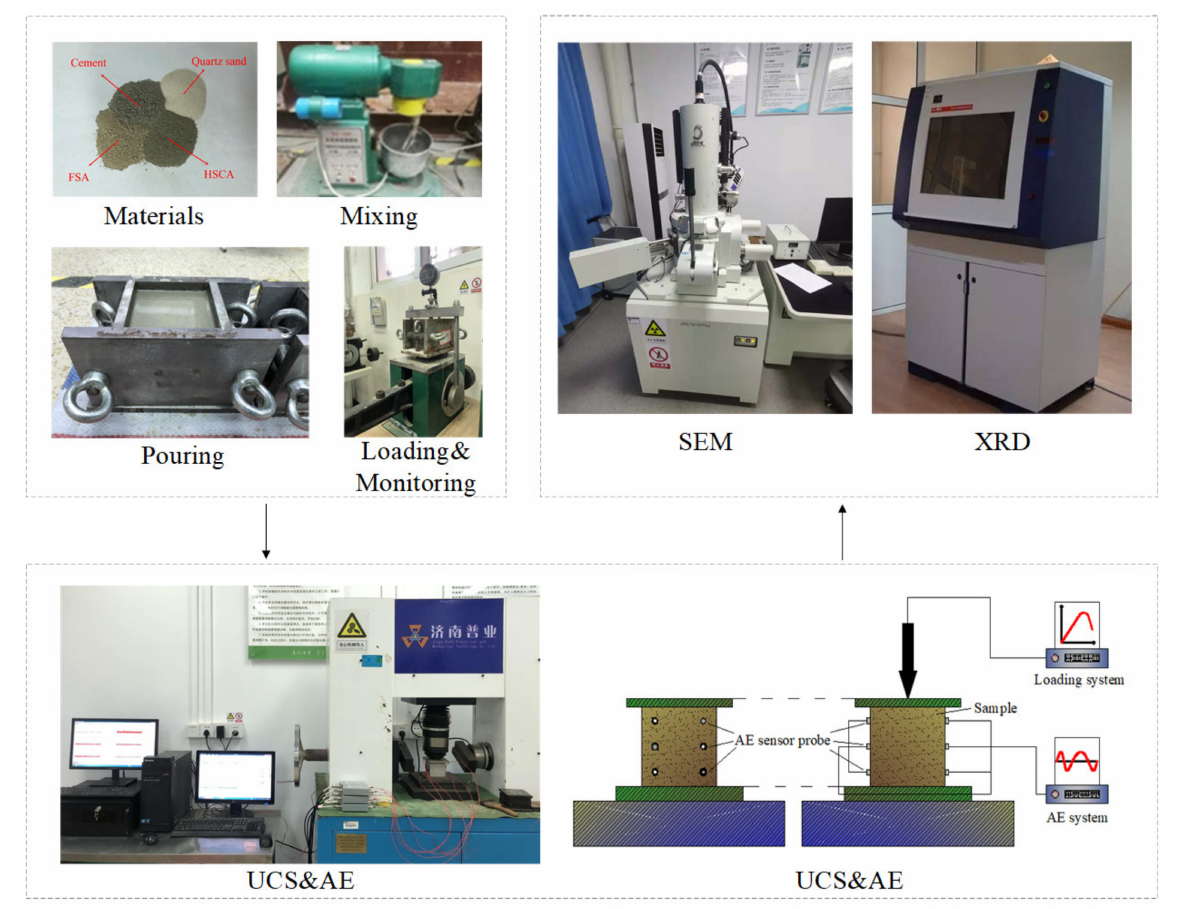
Figure 1. Test process.